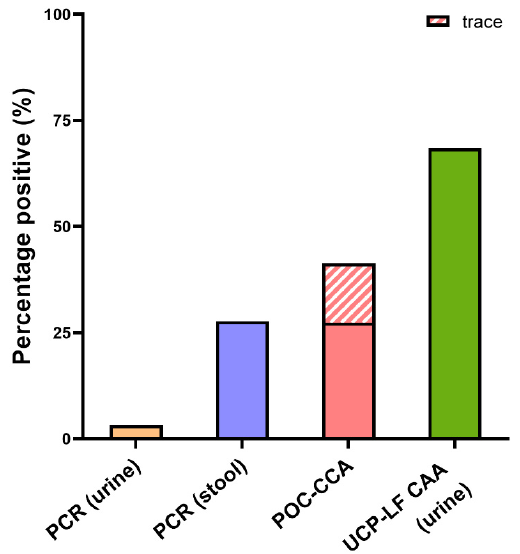
Figure 1. Percentage positive by polymerase chain reaction (PCR) in urine and stool, point-of-care circulating cathodic antigen (POC-CCA), and the up-converting lateral flow circulating anodic antigen (UCP-LF CAA) test in 314 individuals. The shaded area represents POC-CCA trace results. Table 1. The intensity of infection based on polymerase chain reaction (PCR) in urine and stool, point-of-care circulating cathodic antigen (POC-CCA), and the up-converting particle, lateral flow circulating anodic antigen (UCP-LF CAA) urine test in 314